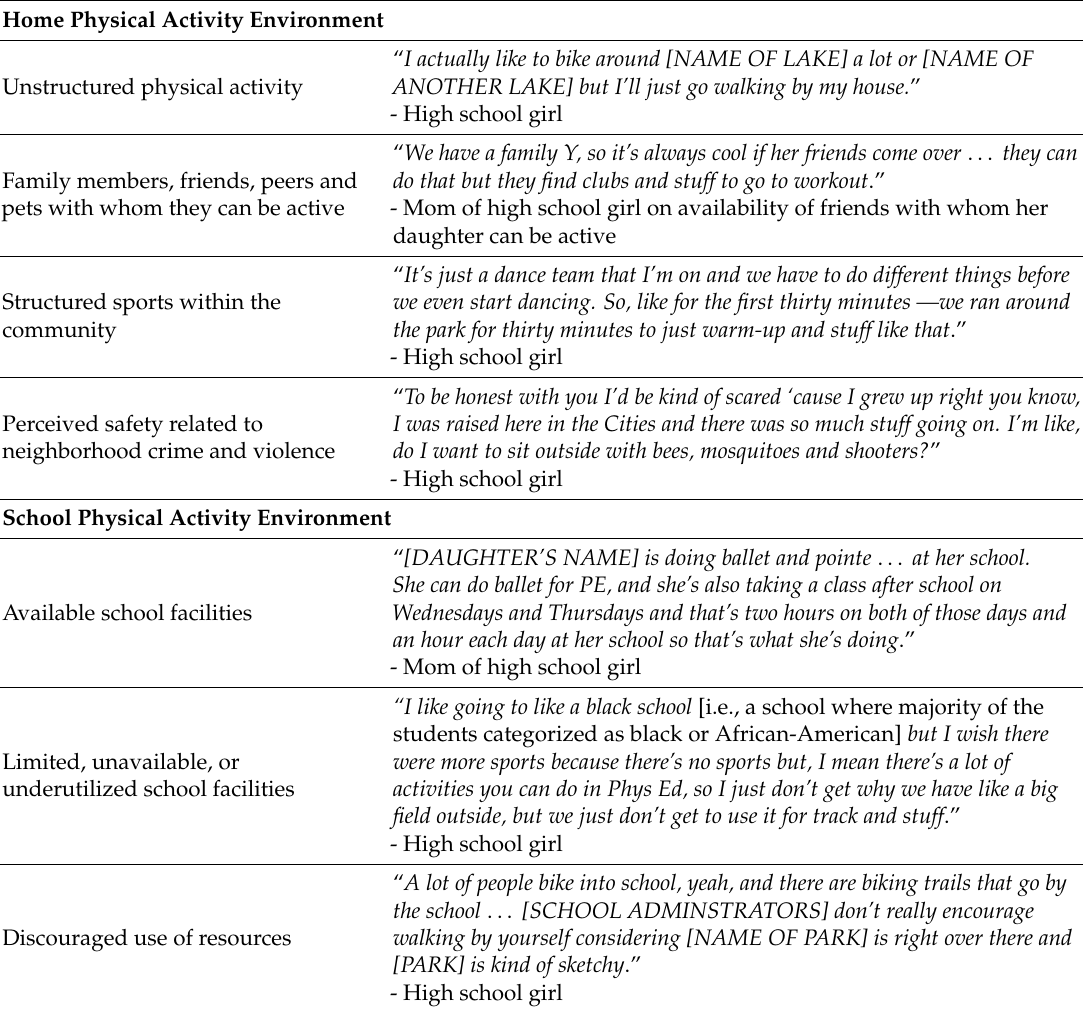
Table 1. Supporting quotes for factors in the home and school environments that influence physical